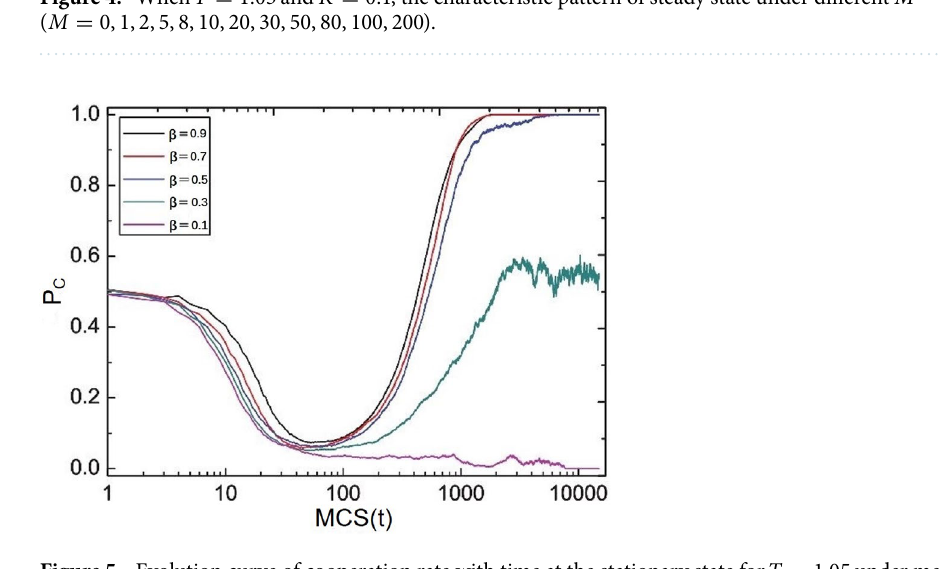
Figure 5. Evolution curve of cooperation rate with time at the stationary state for T = 1.05 under memory length M = 7 , β is fixed to be 0.1, 0.3, 0.5, 0.7,